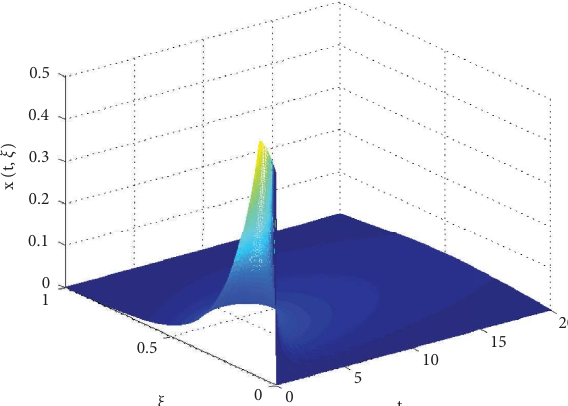
Figure 1: Te state evolution of parabolic distributed parameter